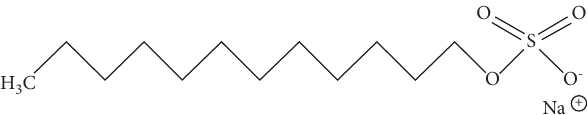
Figure 2: Chemical structure of sodium dodecyl